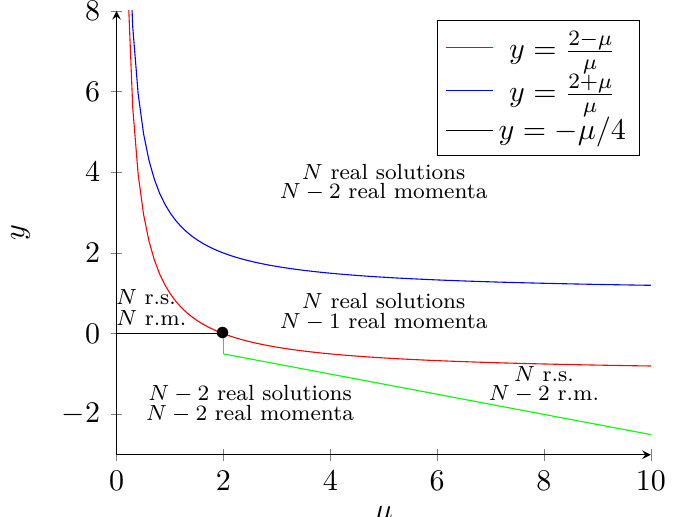
Figure 1 . Reality properties of the solutions and associated momenta of the spectral equation (3.10) in terms of µ and y